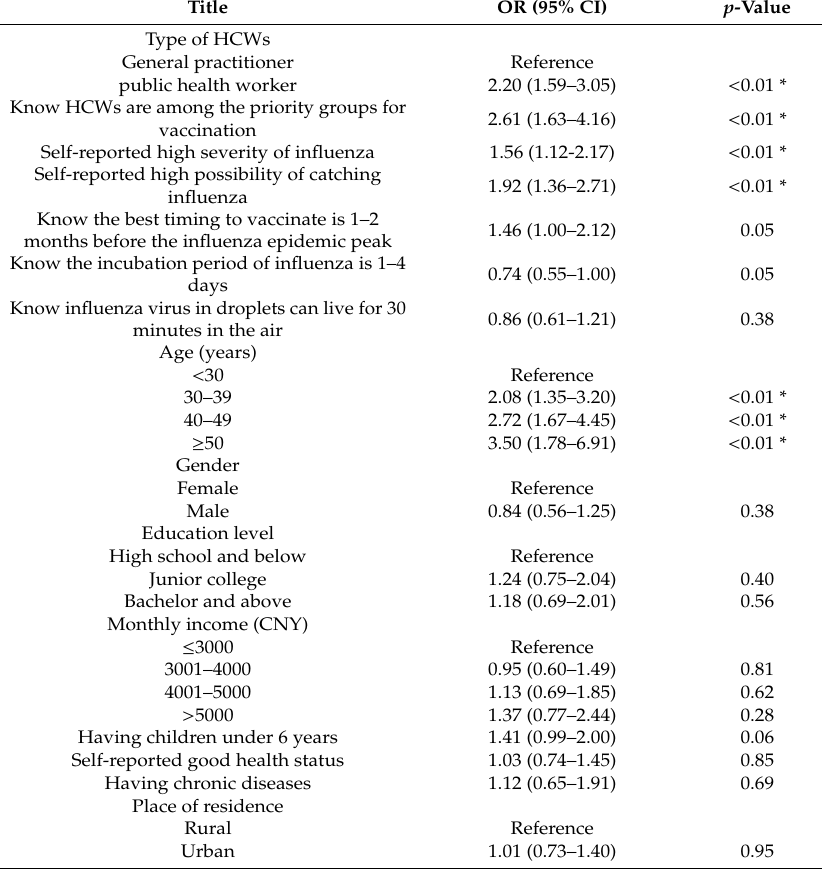
Table 4. Influencing factors of vaccine uptake among HCWs (multiple logistic